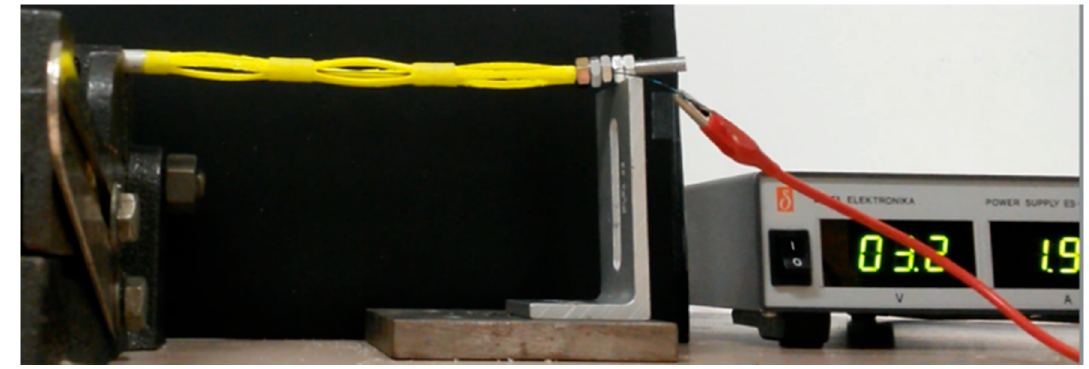
Figure 18. Setup for estimating the transversal displacement produced by the SMA wire.